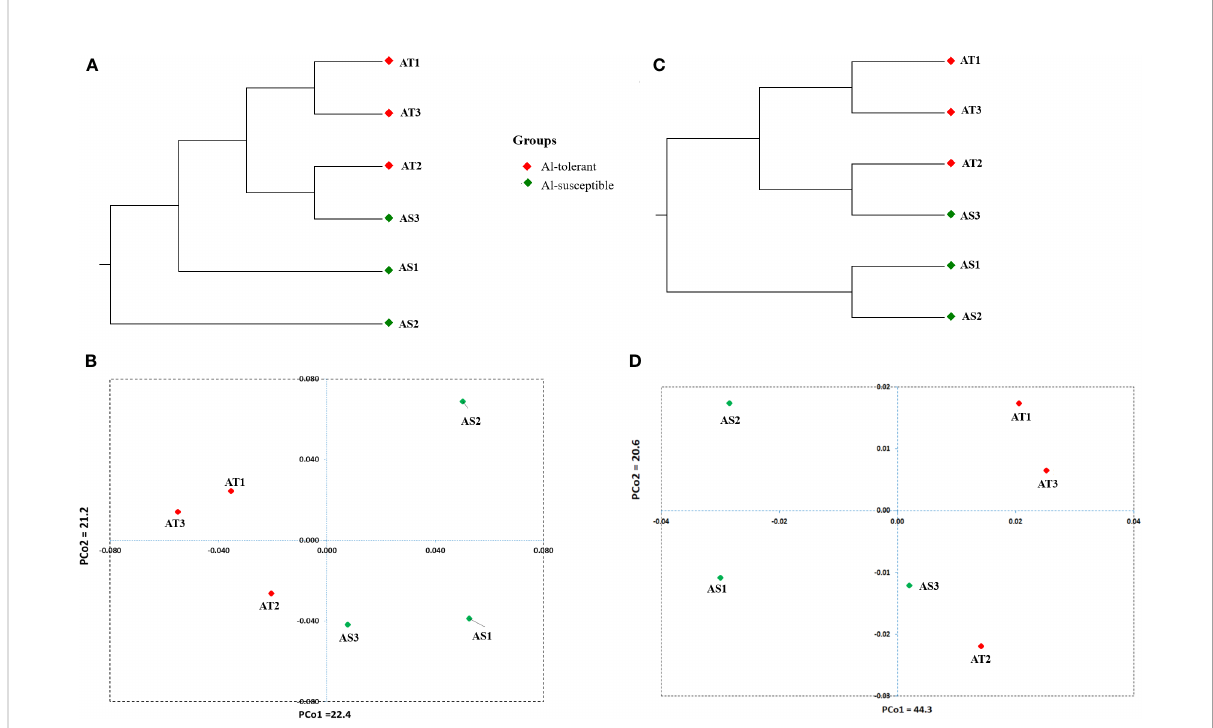
FIGURE 12 Signi fi cantly differentially expressed genes-based UPGMA cluster (A) and PCA scatter plot (B) depicting the relationship between the fi nger millet genotypes. Randomly selected 8000 SNPs based UPGMA cluster (C) and PCA scatter plot (D) depicting the relationship between the fi nger millet